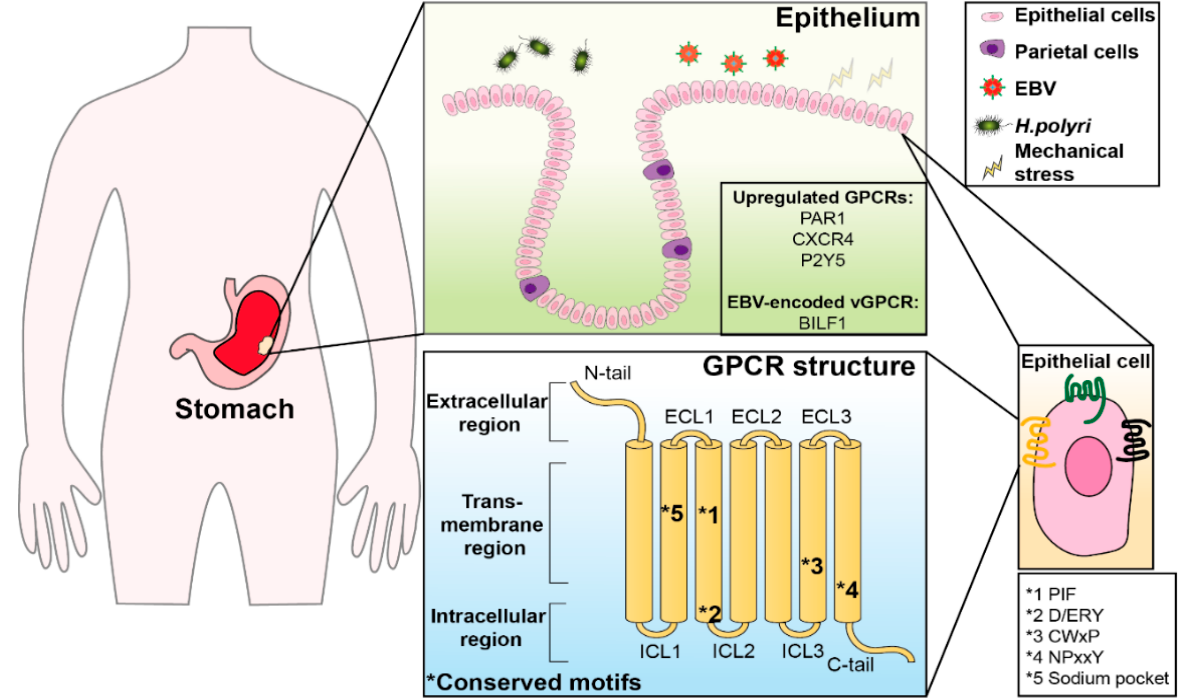
Figure 1. The structure GPCRs and their dysregulation in GC (*, Conserved motifs). GPCRs are widely expressed in the stomach. GPCRs participate in a variety of physiological and pathological processes. The upregulated GPCRs, including PAR1, CXCR4 and P2YR, and BILF1, are identified in GC. The five key sequence motifs in the class A GPCRs represent the most frequent mutant sites, which are conserved and responsible for their structural integrity and essential function.